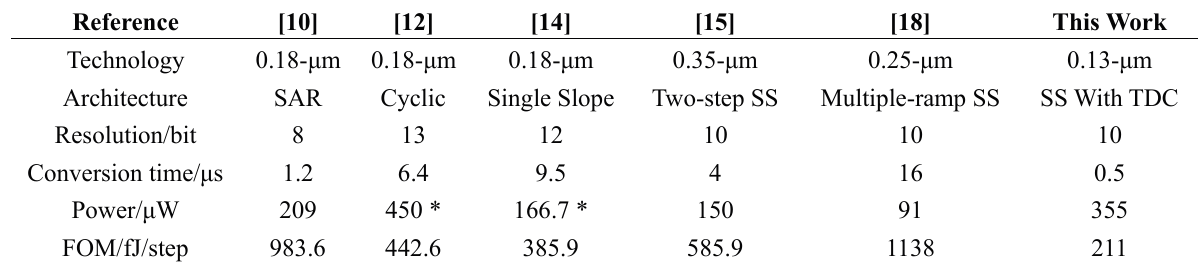
Table 2. Comparison with other types of the column-parallel ADC.